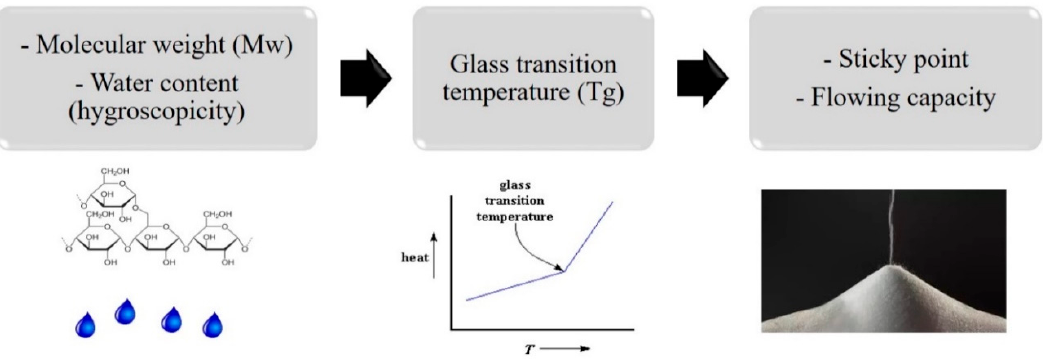
Figure 4. Influence of sugar properties on the flowing behavior of dry particles. Carbohydrates with a high molecular weight (Mw) and a low water content form sugars with a high glass transition temperature (Tg), which will produce a powder after drying with low stickiness and high tendency to flow freely.